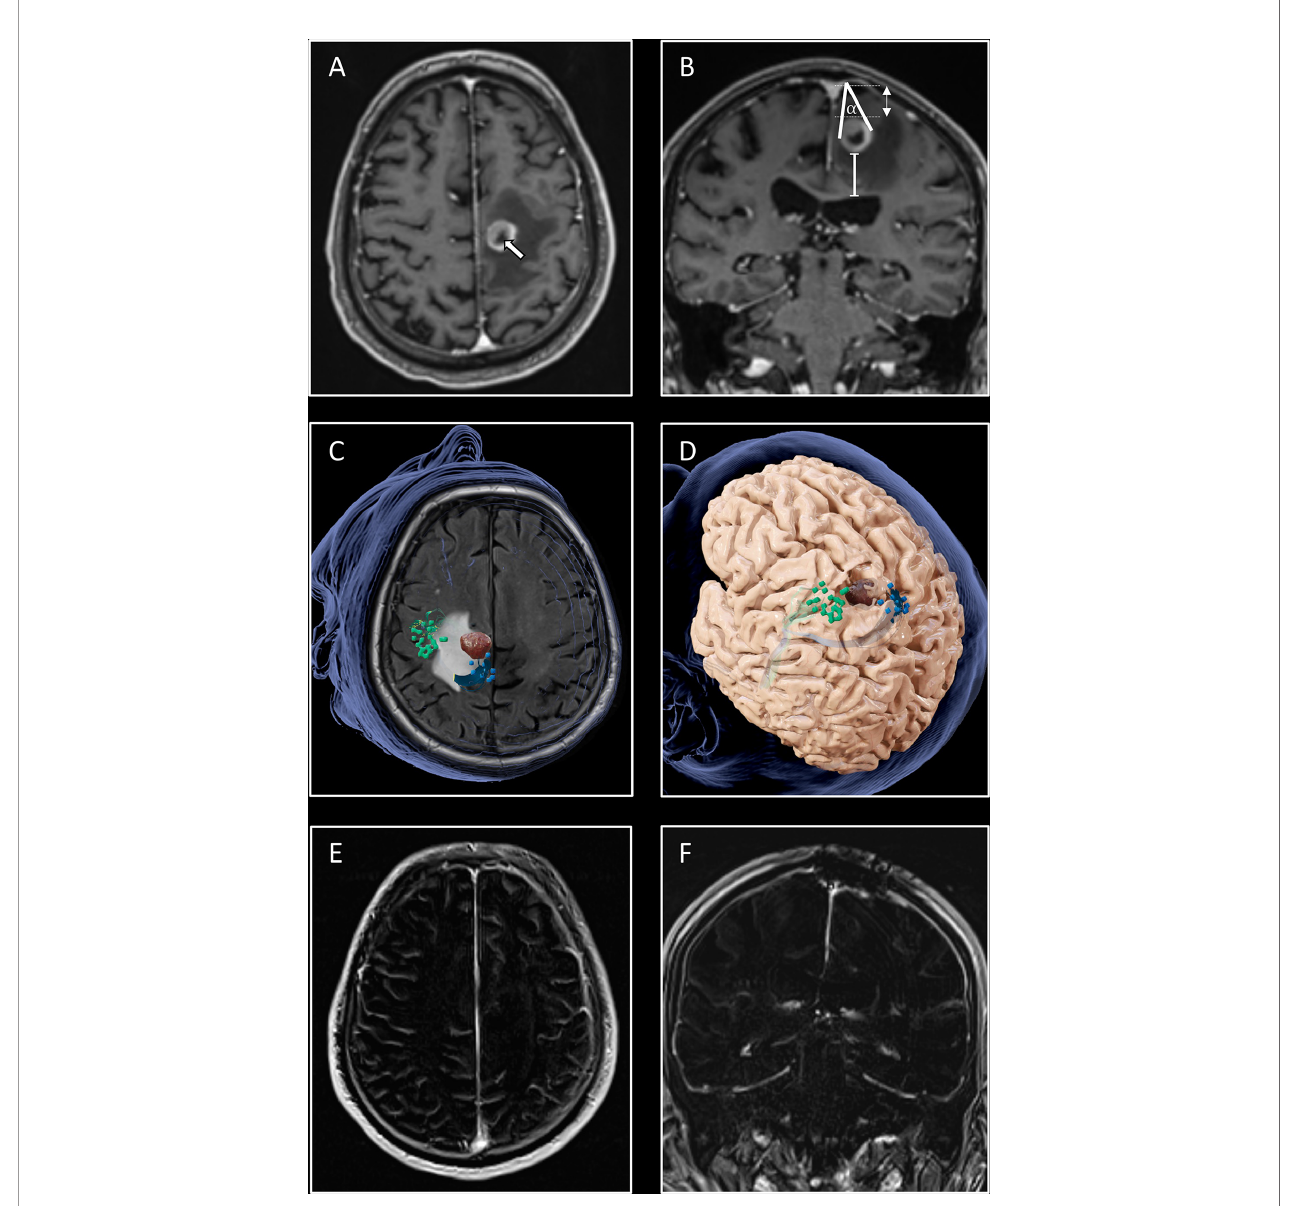
FIGURE 1 | Illustration of the work fl ow. An 80-year-old patient presented to the emergency department with inability to walk and with leg accentuated hemiparesis. MRI (A, B) revealed a circumscribed contrast agent enhancing tumor with a central necrosis (white arrow) in the left hemisphere in precentral locaton. Volume of the tumor (2.5ml), edema (26ml), the distance from the cortex (white double arrow; 19mm) and from the ventricle (white line; 29mm) were measured. The tumor-cortex angle ( a ; 35°) was determined only for subcortical metastases, with the angle legs de fi ned by the largest diameter and the apex de fi ned by the cortical approach. The cortical nTMS motor mapping (C) for the upper (green bullets) and lower extremity (blue bullets) showed approximation of the tumor to the motor cortex. The minimum distance between the tumor and the corticospinal tract was 8mm (D) , indicating a motor-associated location with higher risk for postoperative motor worsening (22). An interhemispheric approach under intraoperative neuromonitoring guidance was chosen for tumor removal. The patient recovered postoperatively with ability to walk again. No residual contrast agent enhancement was detected in the postoperative T1 subtraction sequences, con fi rming a GTR (E, F)